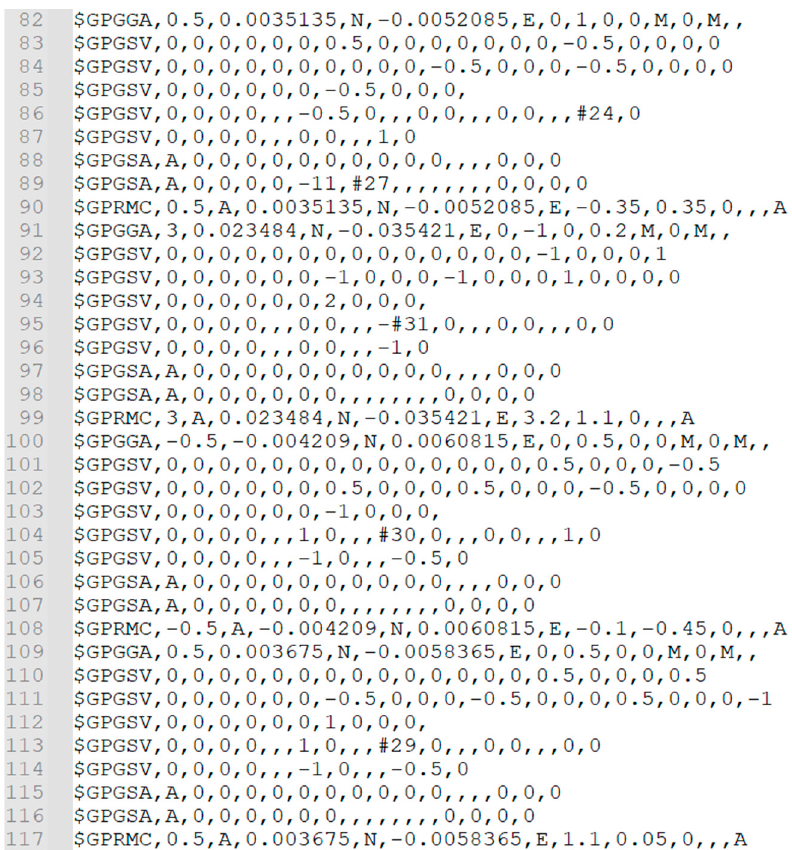
Figure A6. Difference file (Diff file).